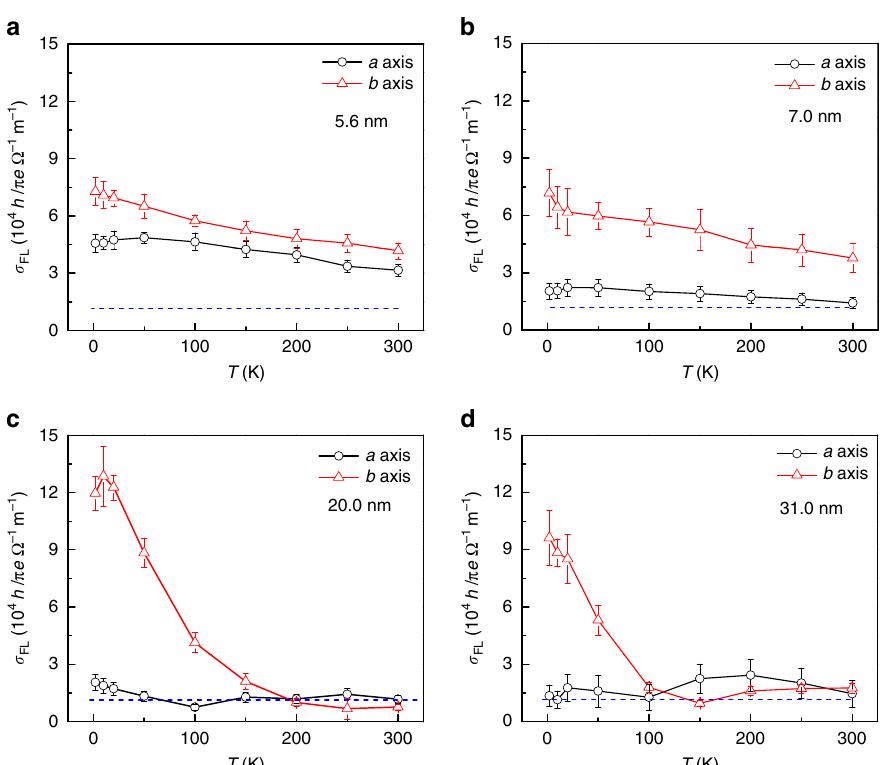
Fig. 5 Anisotropic spin conductivity in WTe 2 /Py devices. The spin conductivity σ FL calculated using the extracted FL torque in WTe 2 /Py with the current along the a - and b -axes. The thicknesses of the WTe 2 in the Hall devices are 5.6 nm ( a ), 7.0 nm ( b ), 20.0 nm ( c ), and 31.0 nm ( d ), respectively. The thickness of the Py in the devices is 6 nm. The dashed blue line represents the spin conductivity calculated using the estimated Oersted fi eld. The error bar represents the combination of the 20% standard error and the fi tting